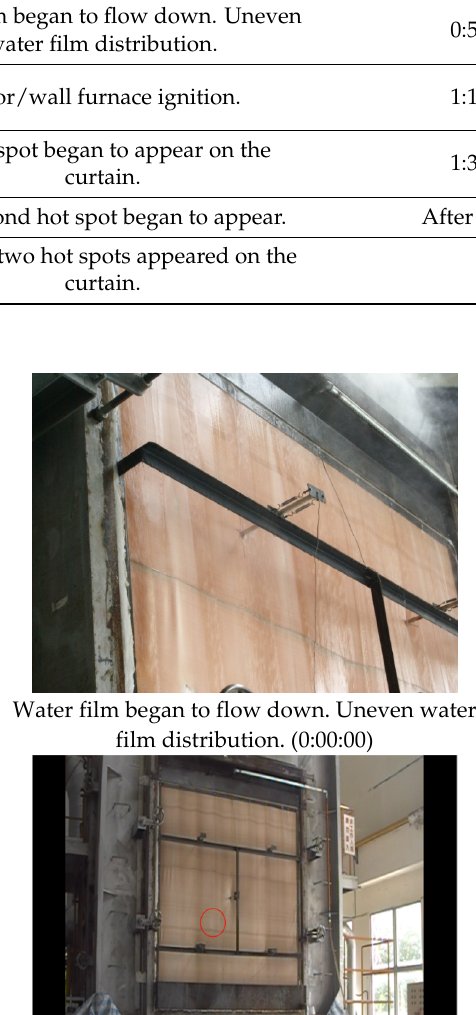
Table 3. The experimental record.